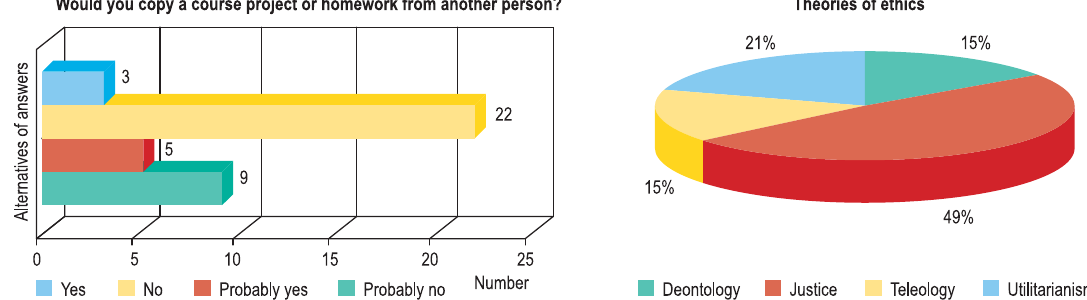
Fig. 2. Copying of a course project or homework ( on the left ) and theories of ethics selected by the students ( on the right